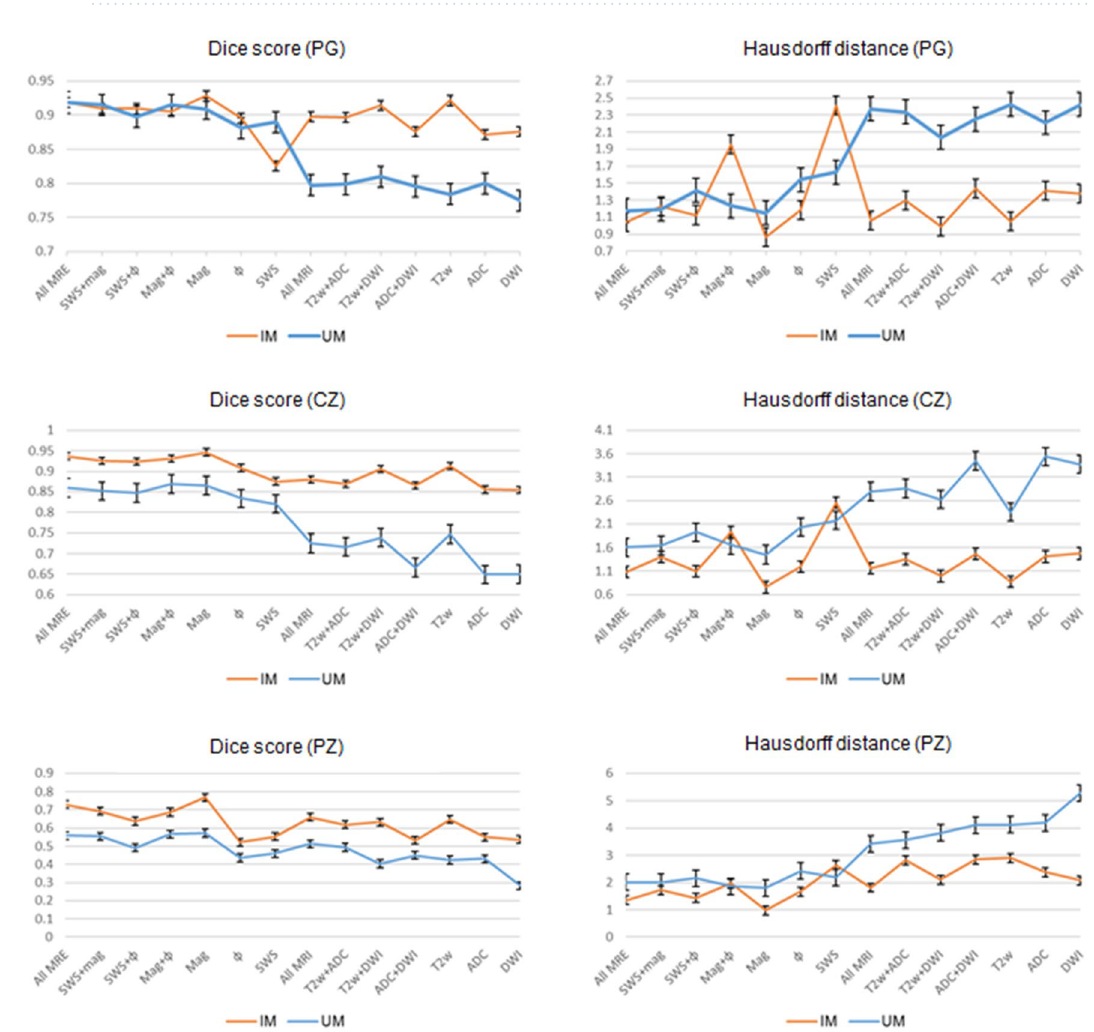
Figure 7. Comparison of the performance of the two approaches: IMs with orange and UM with blue color. The left and right figures show the values of dice score and Hausdorff distance,